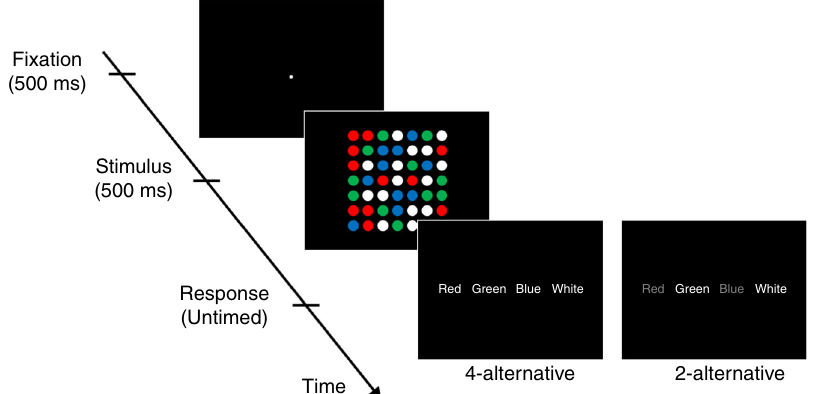
Fig. 2 Task for Experiment 1. Each trial consisted of a fi xation period (500 ms), stimulus presentation (500 ms), and untimed response period. The stimulus comprised of 49 circles each colored in one of four different colors (red, green, blue, and white). One of the colors (white in this example) was presented more frequently (16 circles; dominant color) than the other colors (11 circles each; nondominant colors). The task was to indicate the dominant color. Two conditions were presented in different blocks. In the four-alternative condition, subjects chose between all four colors. In a separate two- alternative condition, on each trial subjects were given a choice between the dominant and one randomly chosen nondominant We further compared the models ’ fi ts to the whole distribution model being 7.26 × 10 168 times more likely in the group. Note of responses. We found that the Akaike Information Criterion that since the population and summary models had the same (AIC) favored the summary model by an average of 24.30 points number of parameters, the same results would be obtained (Fig. 4c), which corresponds to the summary model being 1.89 × regardless of the exact metric employed (e.g., the BIC differences 10 5 times more likely than the population model for the average would be exactly the same; see “ Methods ” for details). subject. Across the whole group of 32 subjects, the total AIC Finally, we constructed and tested four additional difference was thus 777.63 points, corresponding to the summary models. The fi rst two models postulated that decision-making